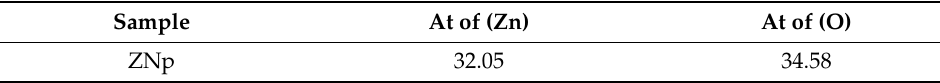
Figure 5. EDAX Spectrum of Zno Nps. Table 3. EDAX Analysis for Zinc Nanoparticles.